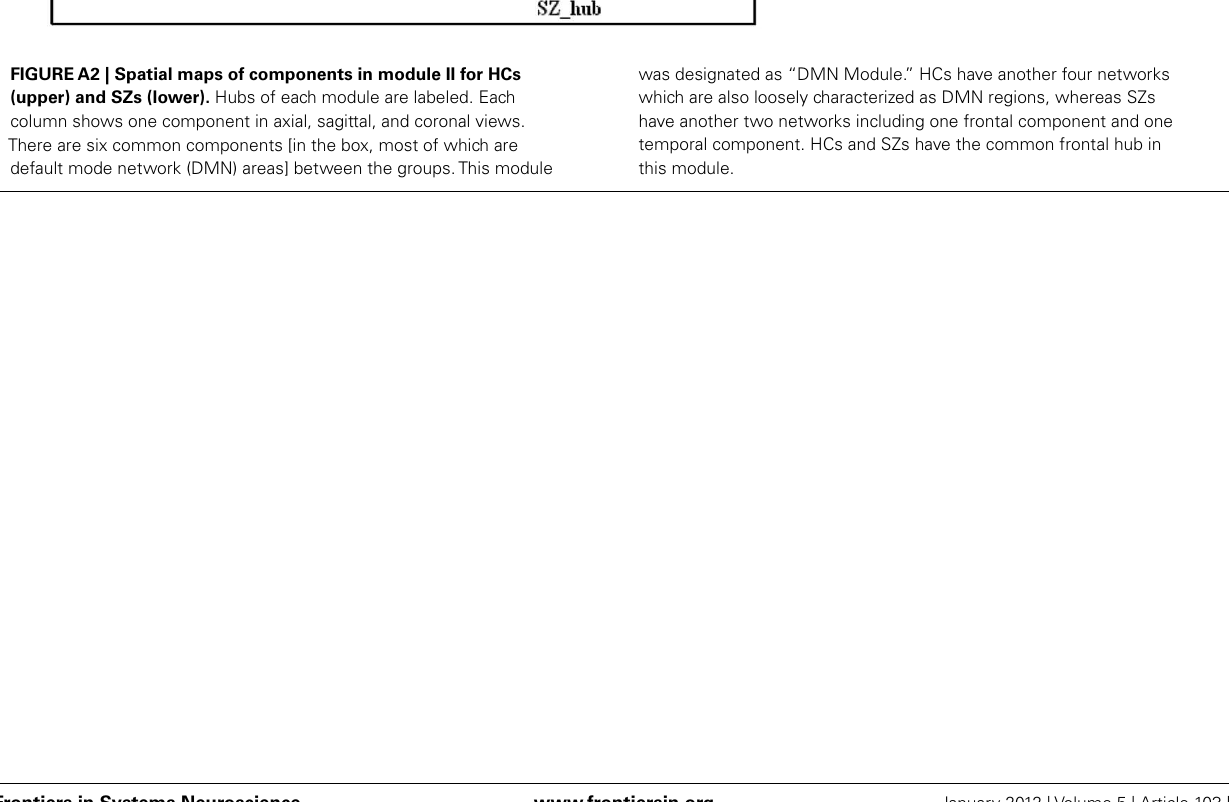
was designated as “DMN Module.” HCs have another four networks which are also loosely characterized as DMN regions, whereas SZs have another two networks including one frontal component and one temporal component. HCs and SZs have the common frontal hub in this